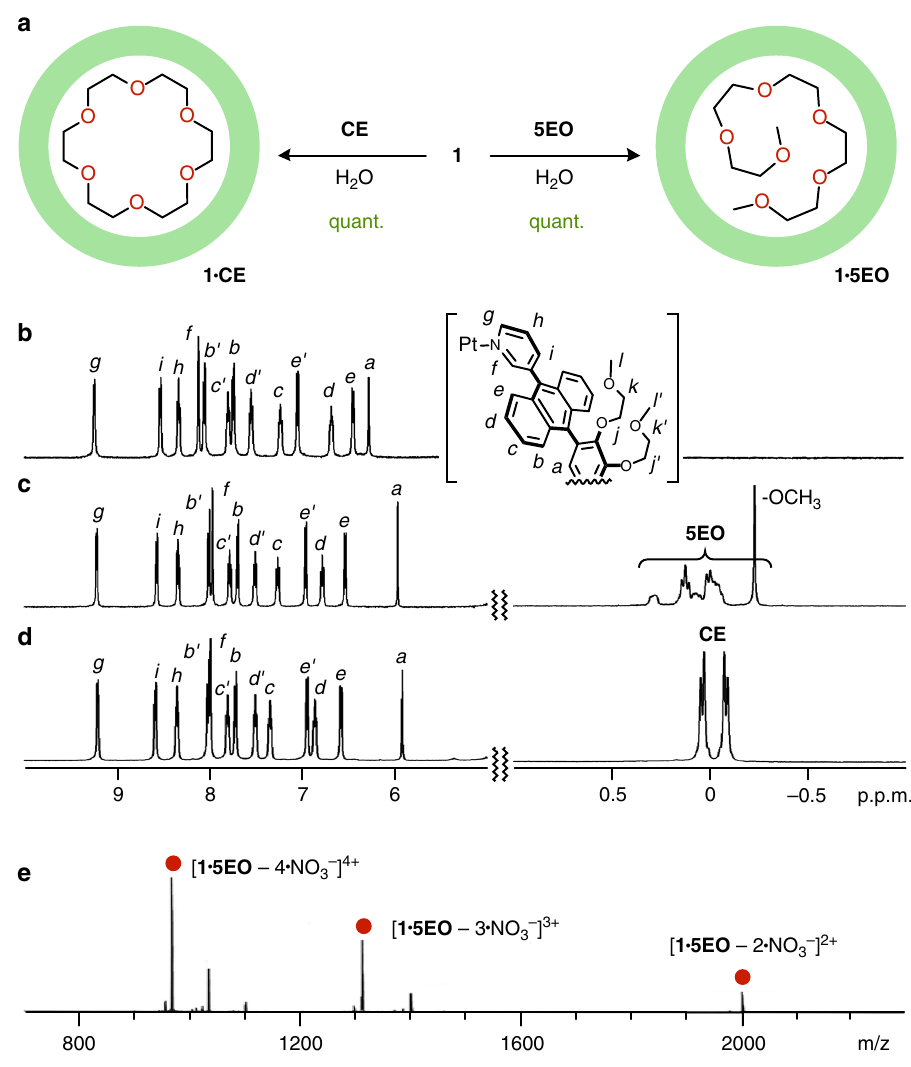
Fig. 2 Formation and characterization of host – guest complexes 1 (cid:129) 5EO and 1 (cid:129) CE in a cramming fashion. a Schematic representation of the formation of 1:1 host – guest complexes 1 (cid:129) 5EO and 1 (cid:129) CE in water. 1 H NMR spectra (500 MHz, D 2 O, room temperature) of b 1 , c 1 (cid:129) 5EO , and d 1 (cid:129) CE . e ESI-TOF MS spectrum (H 2 O, room temperature) of 1 (cid:129)